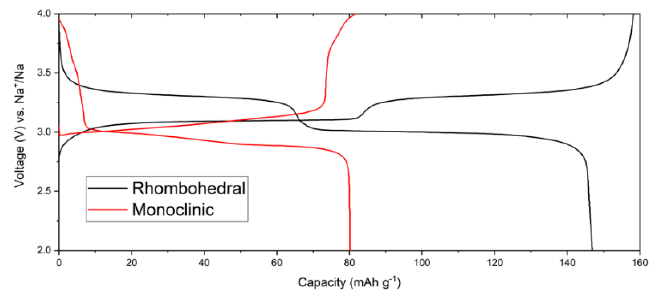
Figure 2. Voltage profiles of Prussian blue in half-cell pouch-cell using sodium metal anode with a hydrated monoclinic cathode in red and a dehydrated rhombohedral cathode in